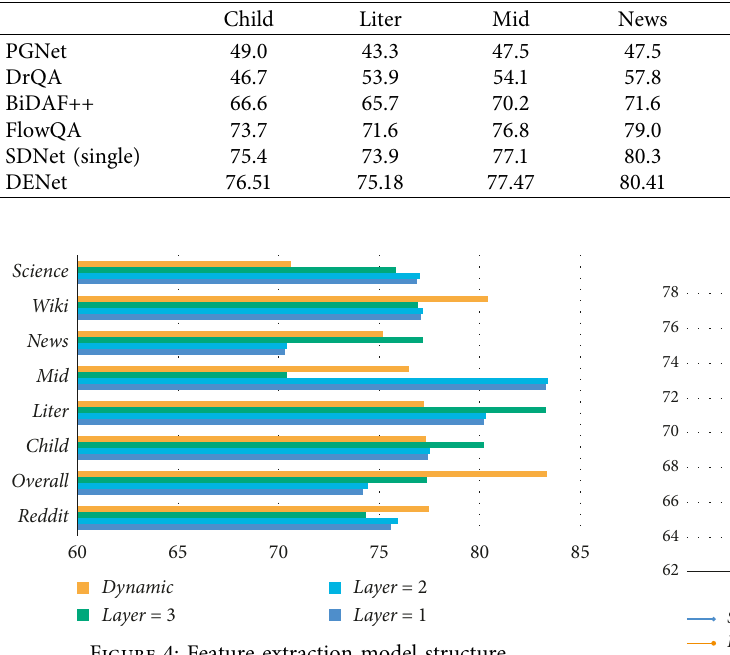
Table 2: Evaluation of the quality of generated answers using the CoQA dataset.